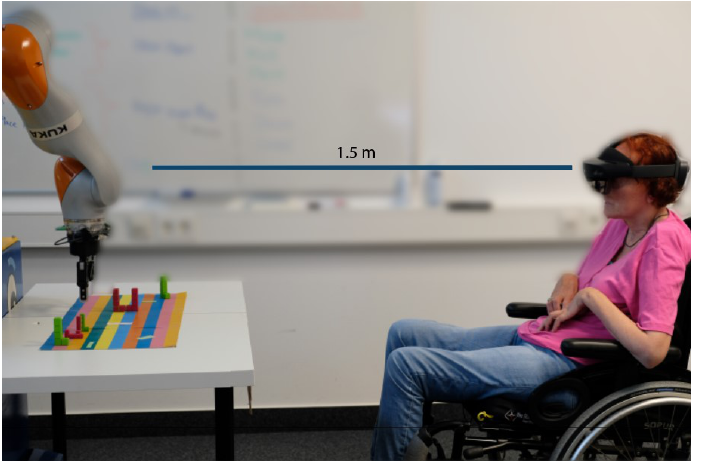
Figure 3. Side view of the scenario with Miss L. wearing the Microsoft HoloLens2 while teleoperating the robotic